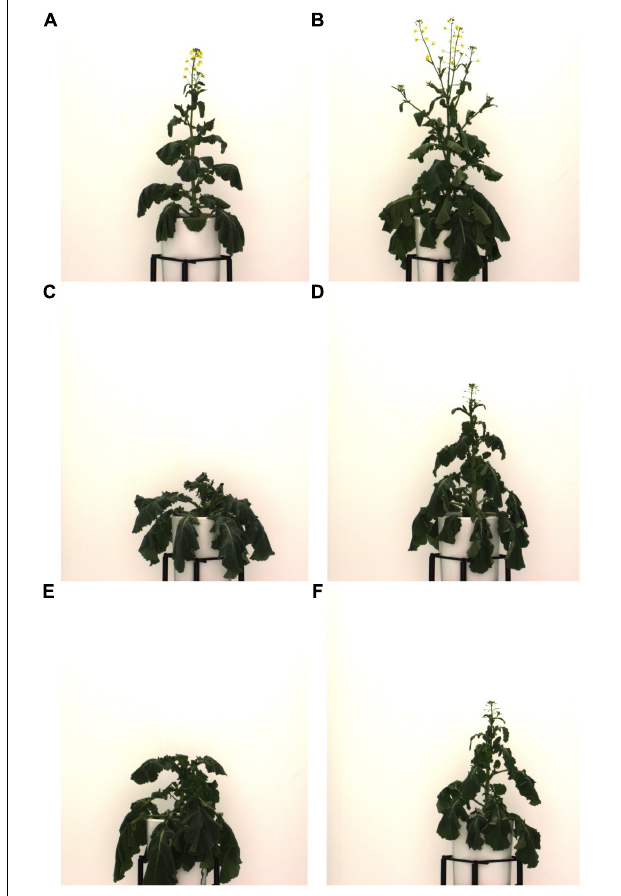
FIGURE 10 | Examples of B. napus individuals exhibiting mild to moderate drought stress on 47 DAS. All images show plants from control group. For further examples of drought stress symptoms, see Supplementary Figure 3.3 . (A) NAM 12, Ind 423; (B) NAM 0, Ind 497; (C) NAM 30, Ind 492; (D) NAM 75, Ind 422; (E) NAM 33, Ind 479; and (F) NAM 75, Ind